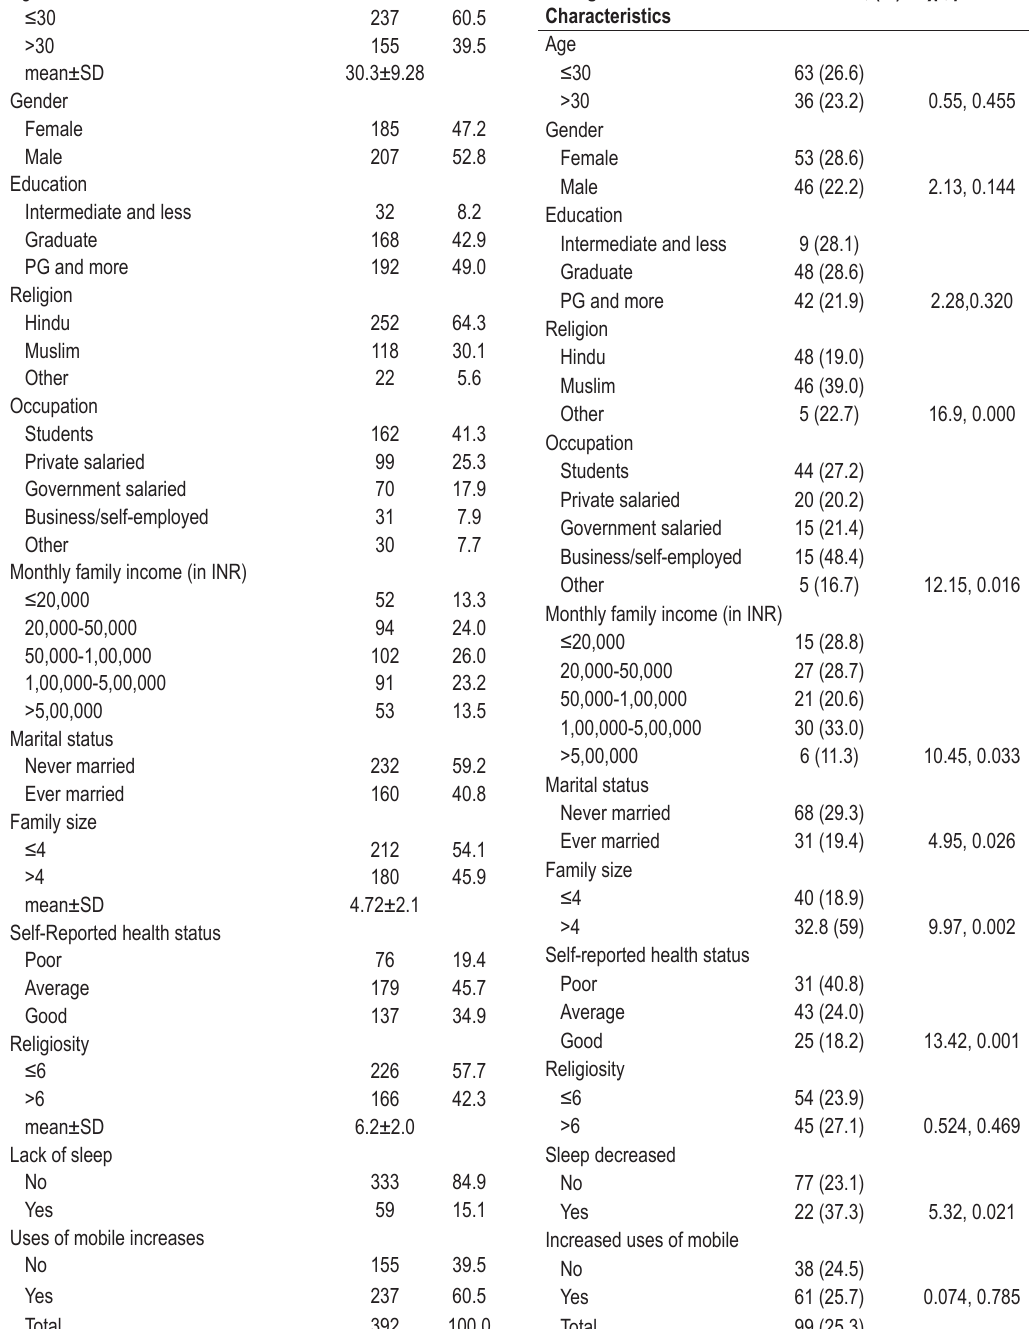
TABLE 3. Prevalence of anxiety with background characteristics